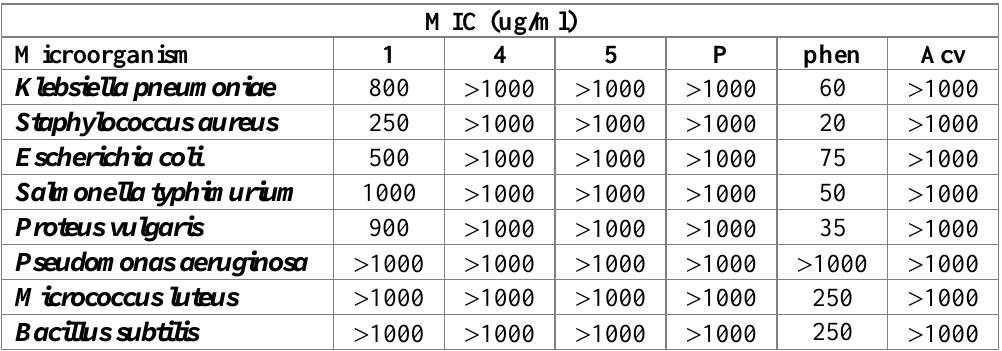
Table S6: Minimal inhibitory concentrations (MIC) of the tested compounds against selected bacteria. n.i. = no